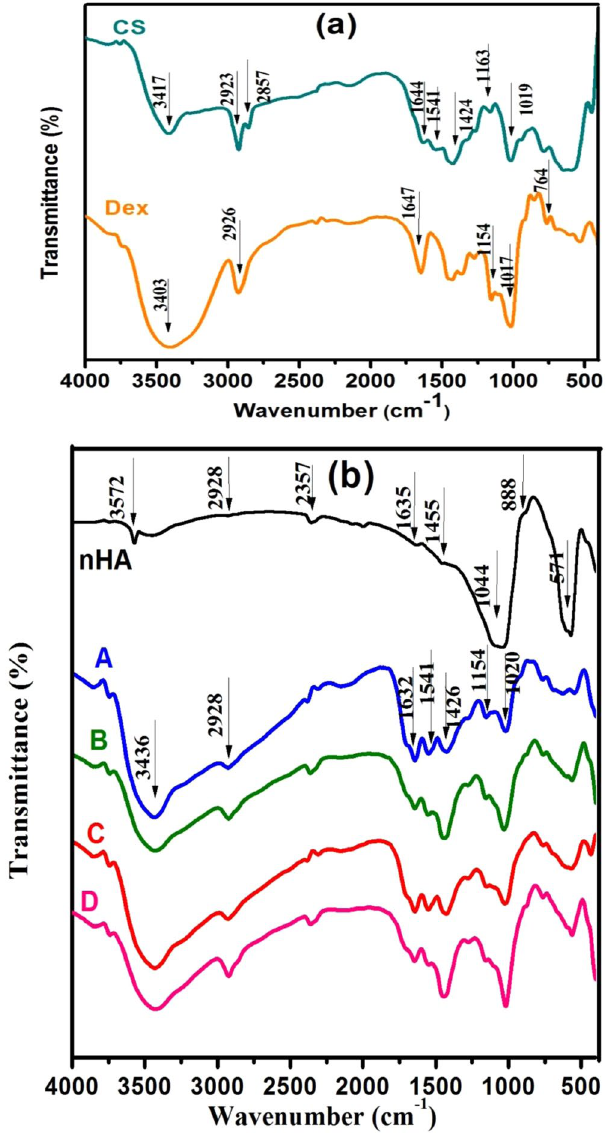
Figure 2. FT-IR spectra of ( a ) Dex and CS. ( b ) Dex-CS/nHA scaffolds with different contents of HA (A) 0, (B) 20, (C) 30 and (D) 40